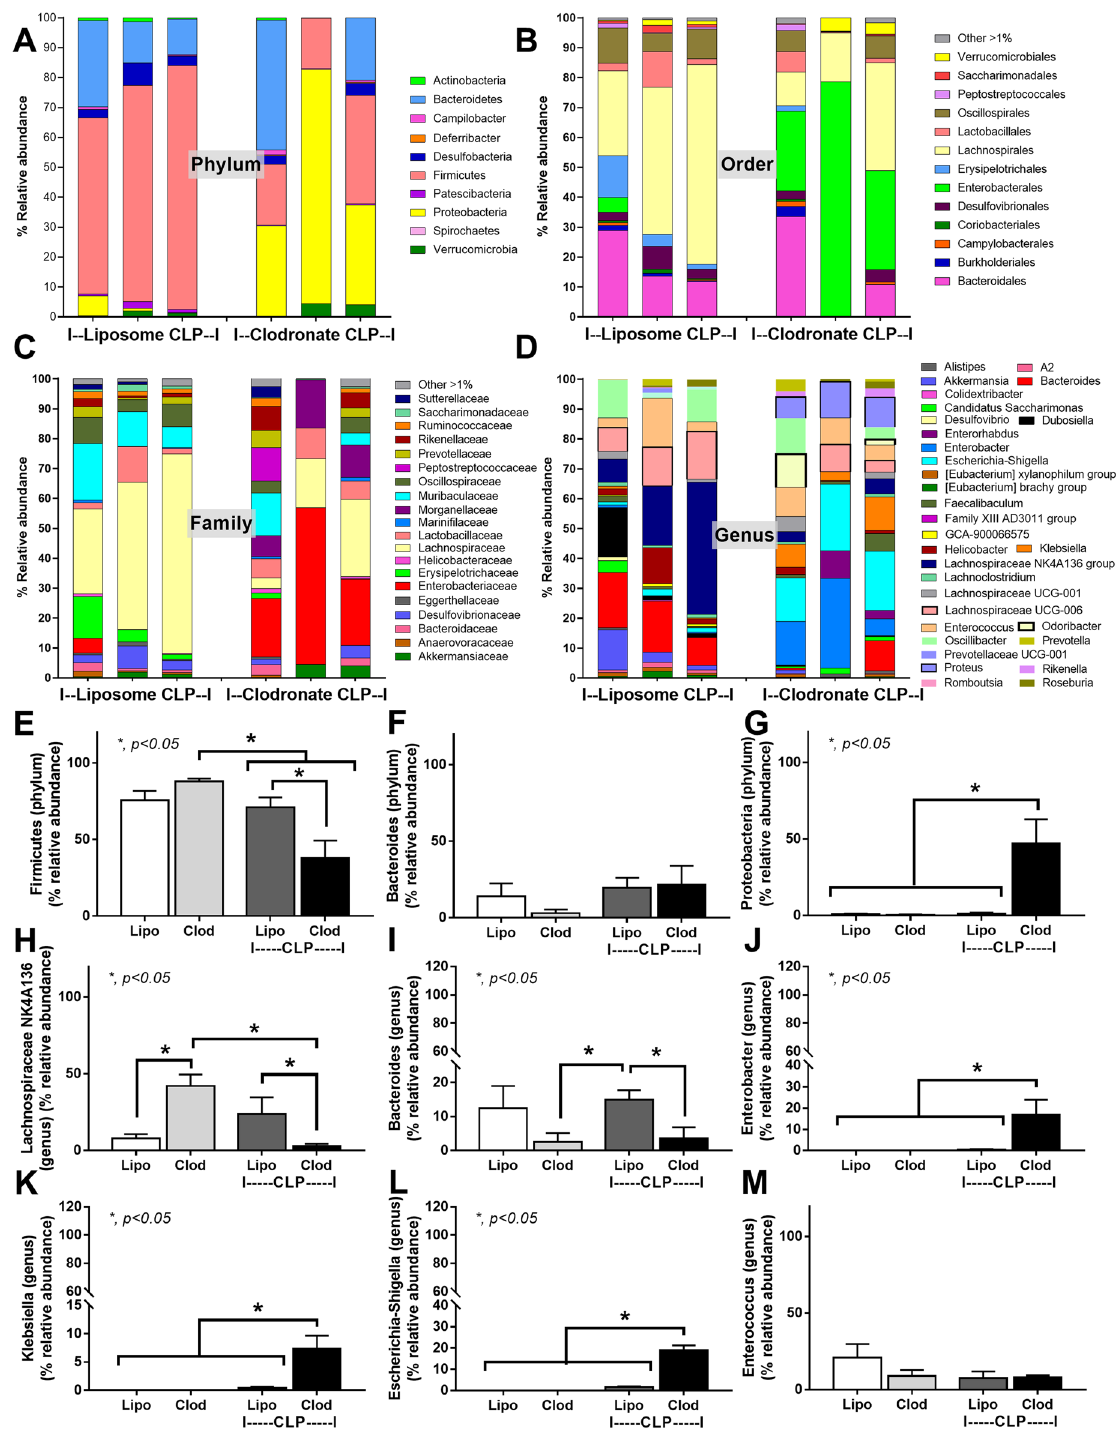
Figure 7. Bacterial microbiome analysis from feces of mice with liposomal clodronate (Clod) or liposome control (Lipo) at 24 h after cecal ligation and puncture (CLP) surgery as indicated by the relative abundance from individual samples in phylum, order, family and genus ( A – D ) with graph presentation of the abundance ( E – M ) are